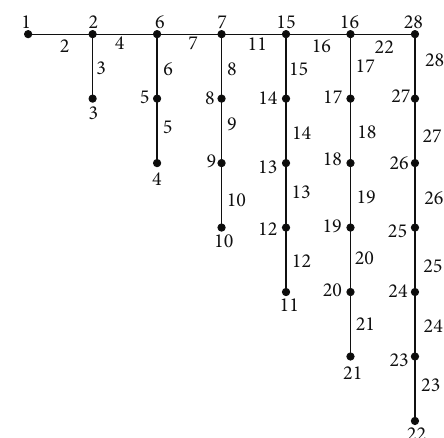
Figure 2: A C -exponential mean labeling of T